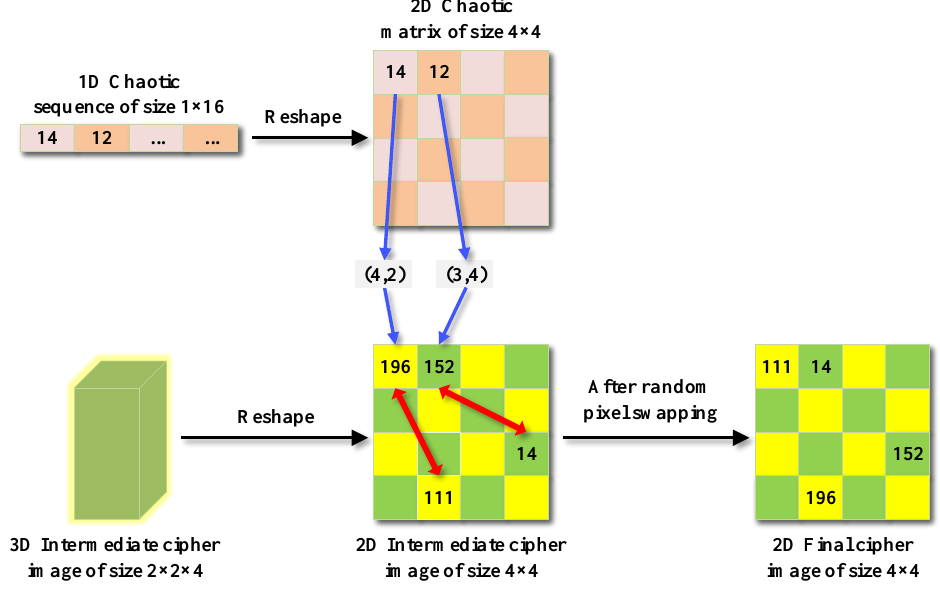
Figure 7. Random Pixel Swapping of